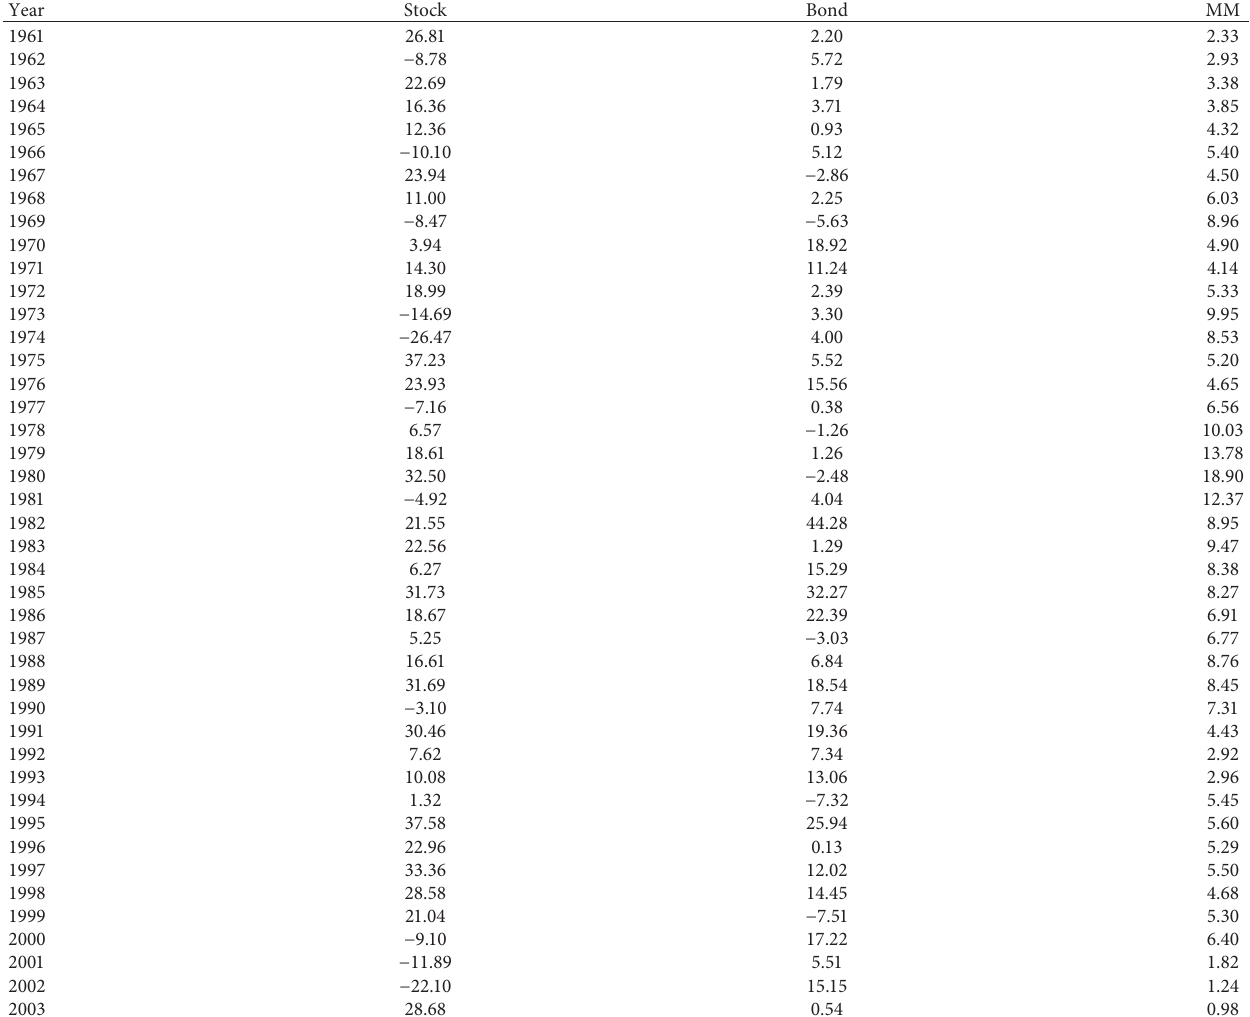
Table 1: Annual rate of return for the portfolio.